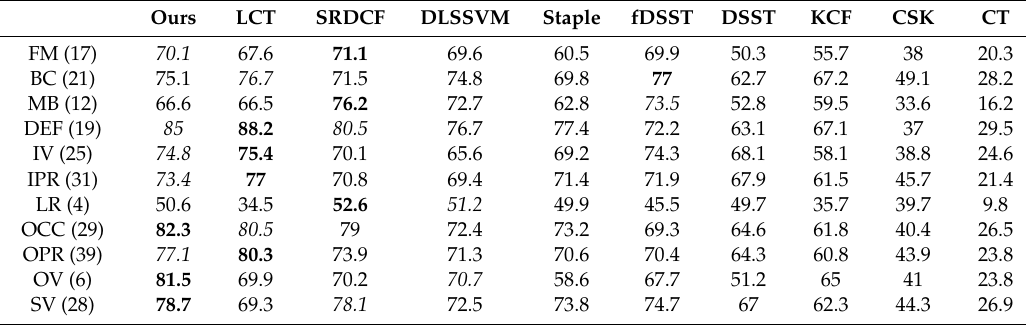
Table 4. Overlap success rate (%) of 11 di ff erent attributes on OTB2013 dataset.